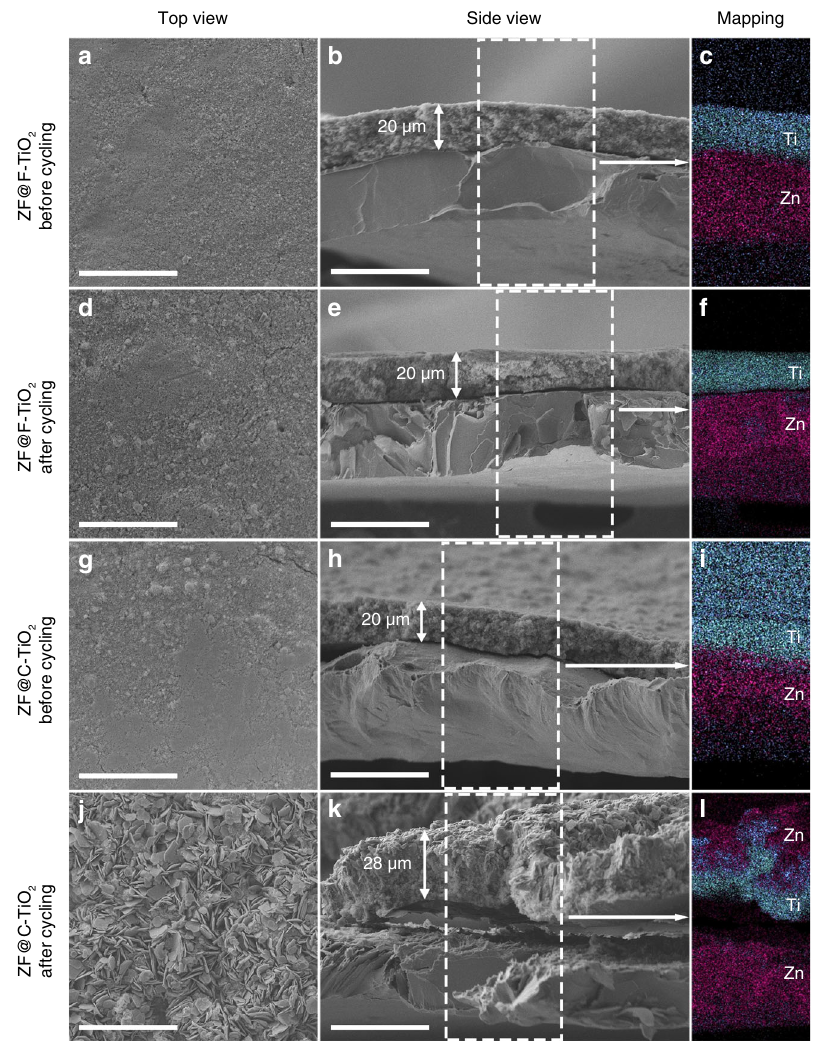
Fig. 3 Morphology evolution of the prepared Zn anodes. SEM and the corresponding EDX mapping images of a – f ZF@F-TiO 2 and g – l ZF@C-TiO 2 before and after 10 cycles in Zn-SS cells. Scale bar: 40 μ